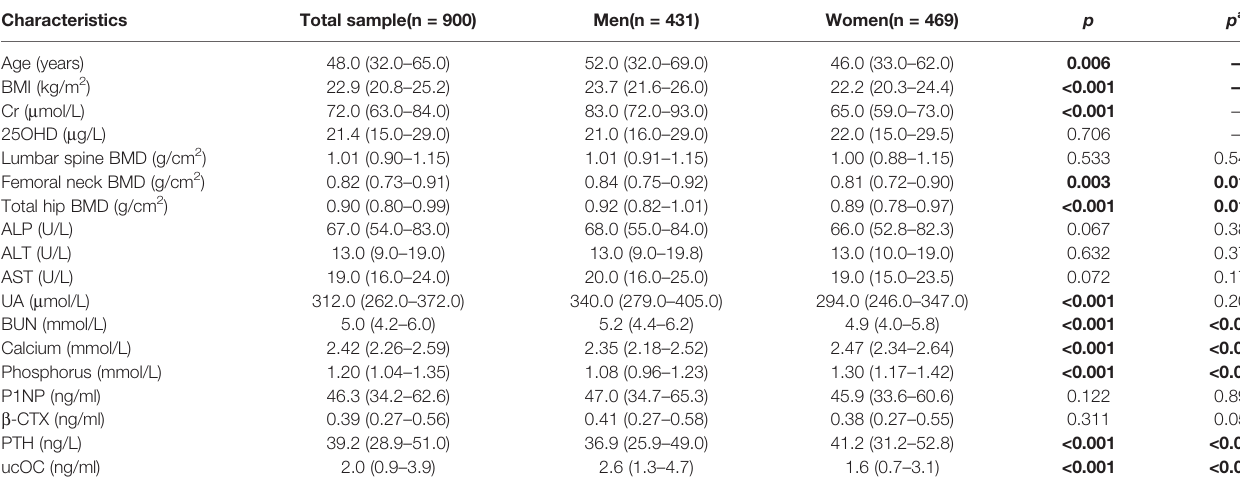
TABLE 1 | Basic characteristics of the 900 participants.